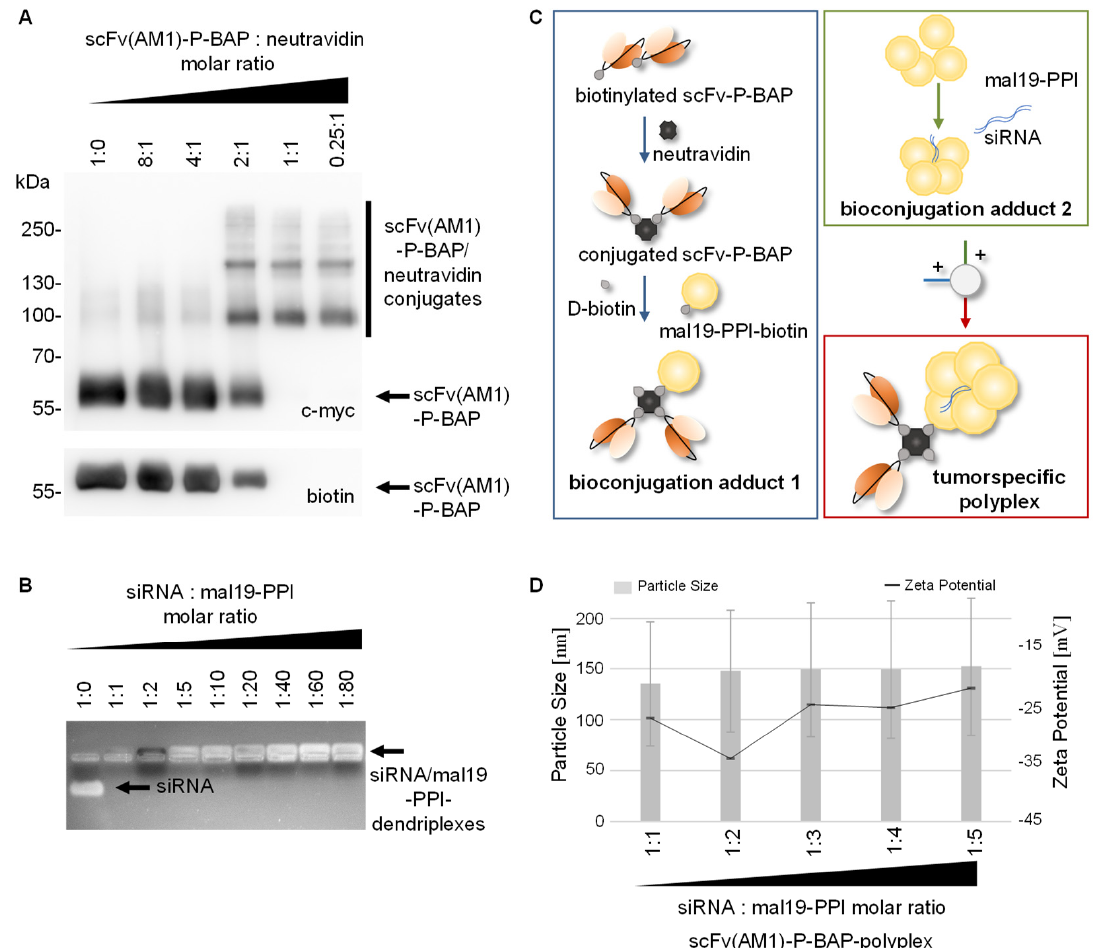
Figure 2. Assembly of scFv(AM1)-P-BAP-guided polyplexes. ( A ) Titration for the binding of scFv(AM1)-P-BAP to neutravidin with increasing molar ratios. Western Blot analysis showing scFv(AM1)-P-BAP/neutravidin complex formation at approximately 100 and 160 kDa or unbound scFv(AM1)-P-BAP at approximately 55 kDa using anti- c-myc and anti-biotin antibodies. ( B ) Electrophoretic mobility gel shift assay of siRNA binding to mal19-PPI. ( C ) Schematic representation of the successive conjugation of scFv(AM1)-P-BAP-guided polyplexes ( D ) Assessment of particle sizes and zeta potential of scFv(AM1)-P-BAP-polyplexes at various siRNA/mal19-PPI molar ratios.